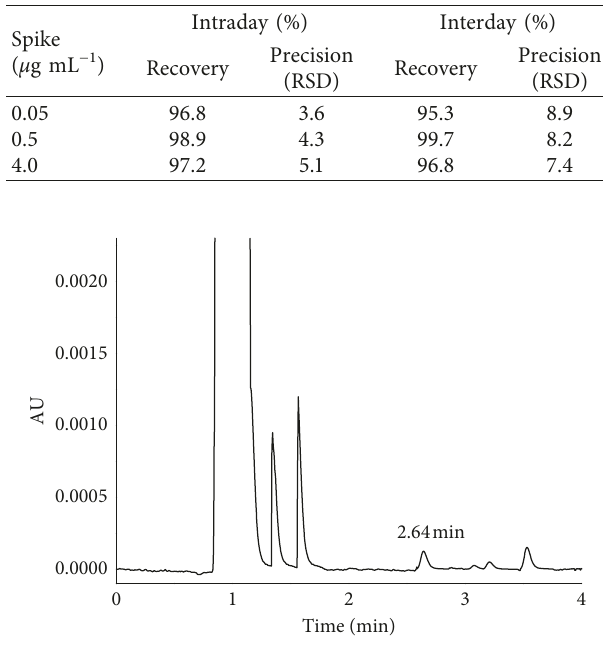
Figure 8: Representative chromatograms of blank plasma without